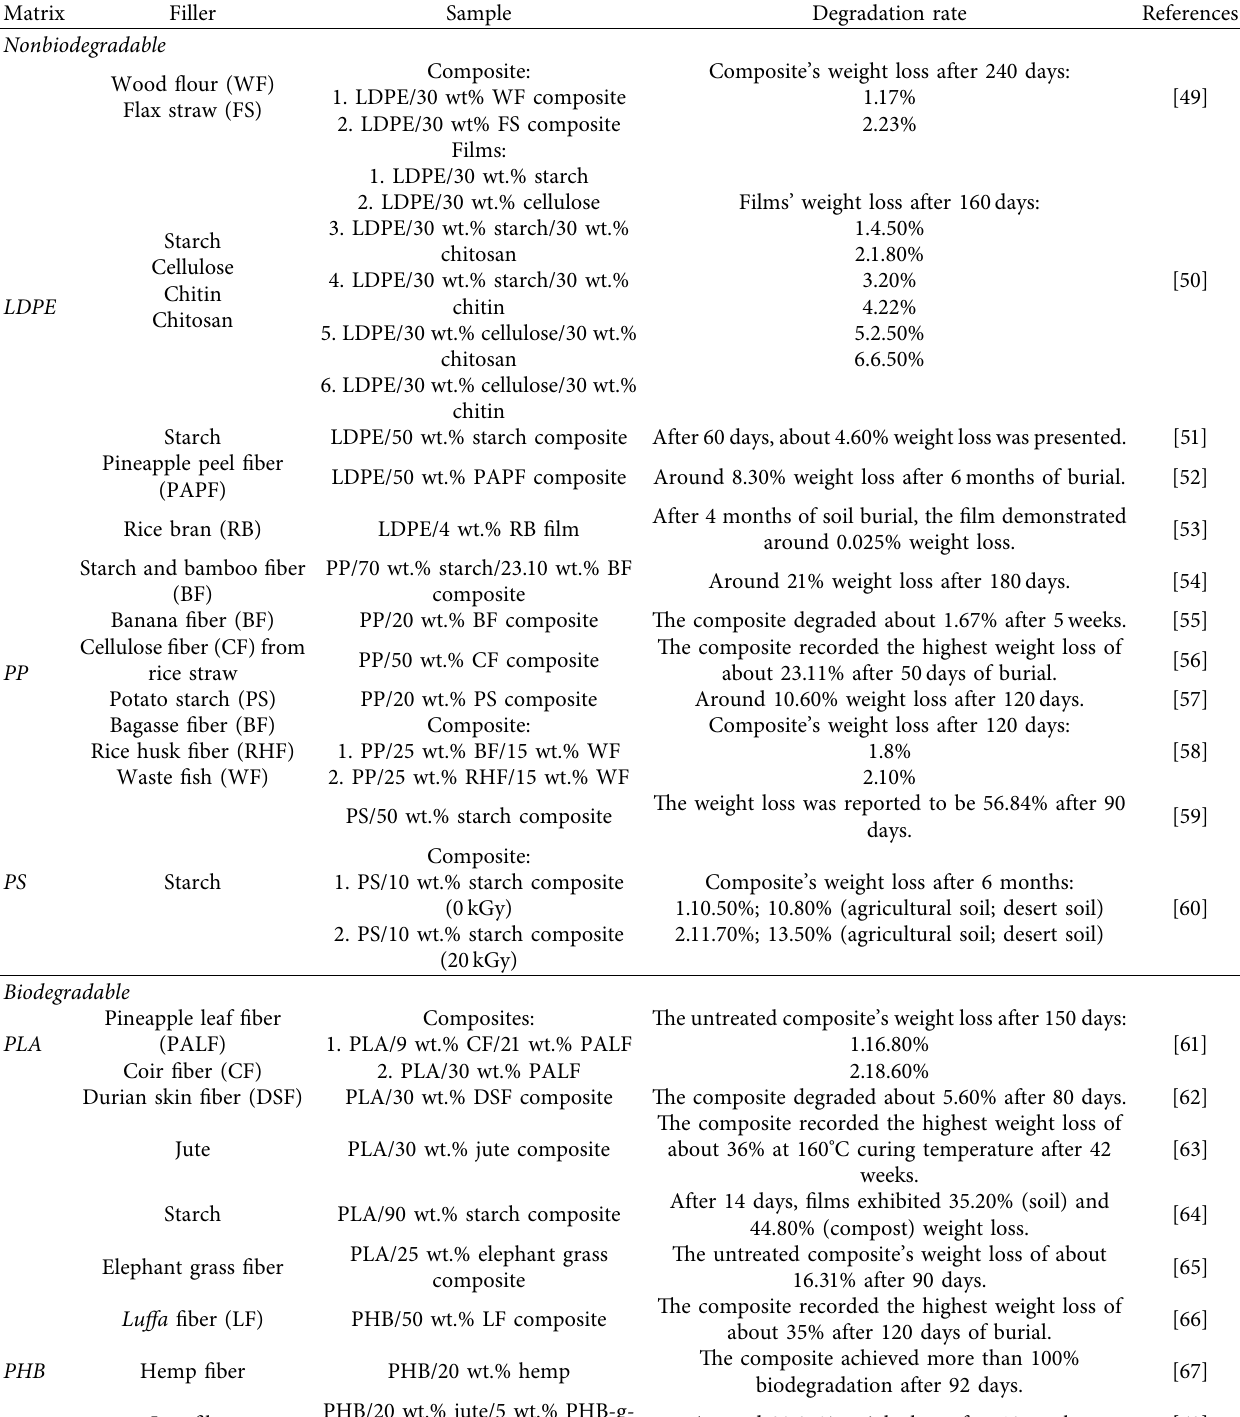
Table 1: Comparison of degradation rate between nonbiodegradable and biodegradable composites by soil burial method. Matrix